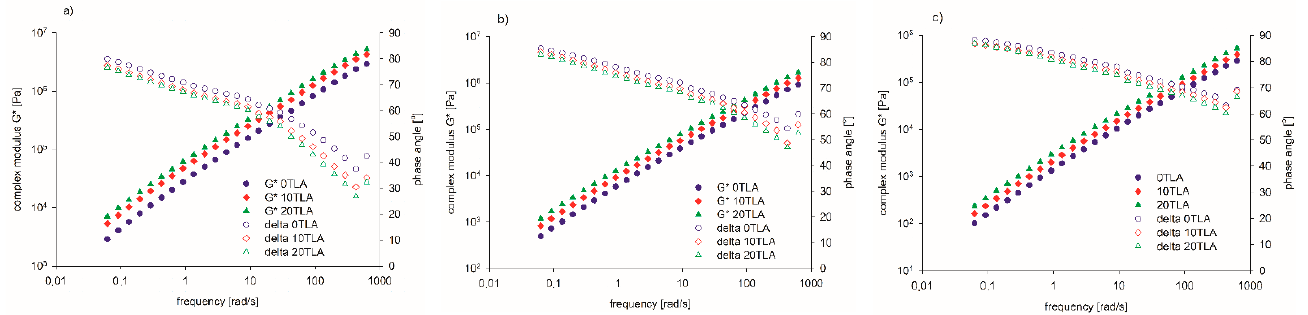
Figure 6. Isothermal curves of TLA-modified binders at ( a ) 40 °C; ( b ) 50 °C; ( c ) 60 °C. The complex modulus (G*) and phase angle ( δ ) of the TLA-modified binders versus test temperature are shown in Figure 7. At a specific test temperature, the complex moduli of the modified binders were higher than that of base bitumen. The G* value increased